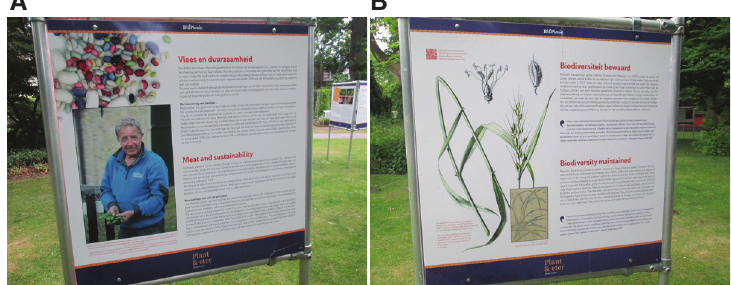
Figure 1 (A) Information panel addressing ‘Meat and Sustainability’ from the Plant-eater exhibition held at Hortus botanicus Leiden; (B) Information panel addressing the issue of biodiversity from the same exhibition (Source: photo- graphs by Georgios Alexopoulos) A B